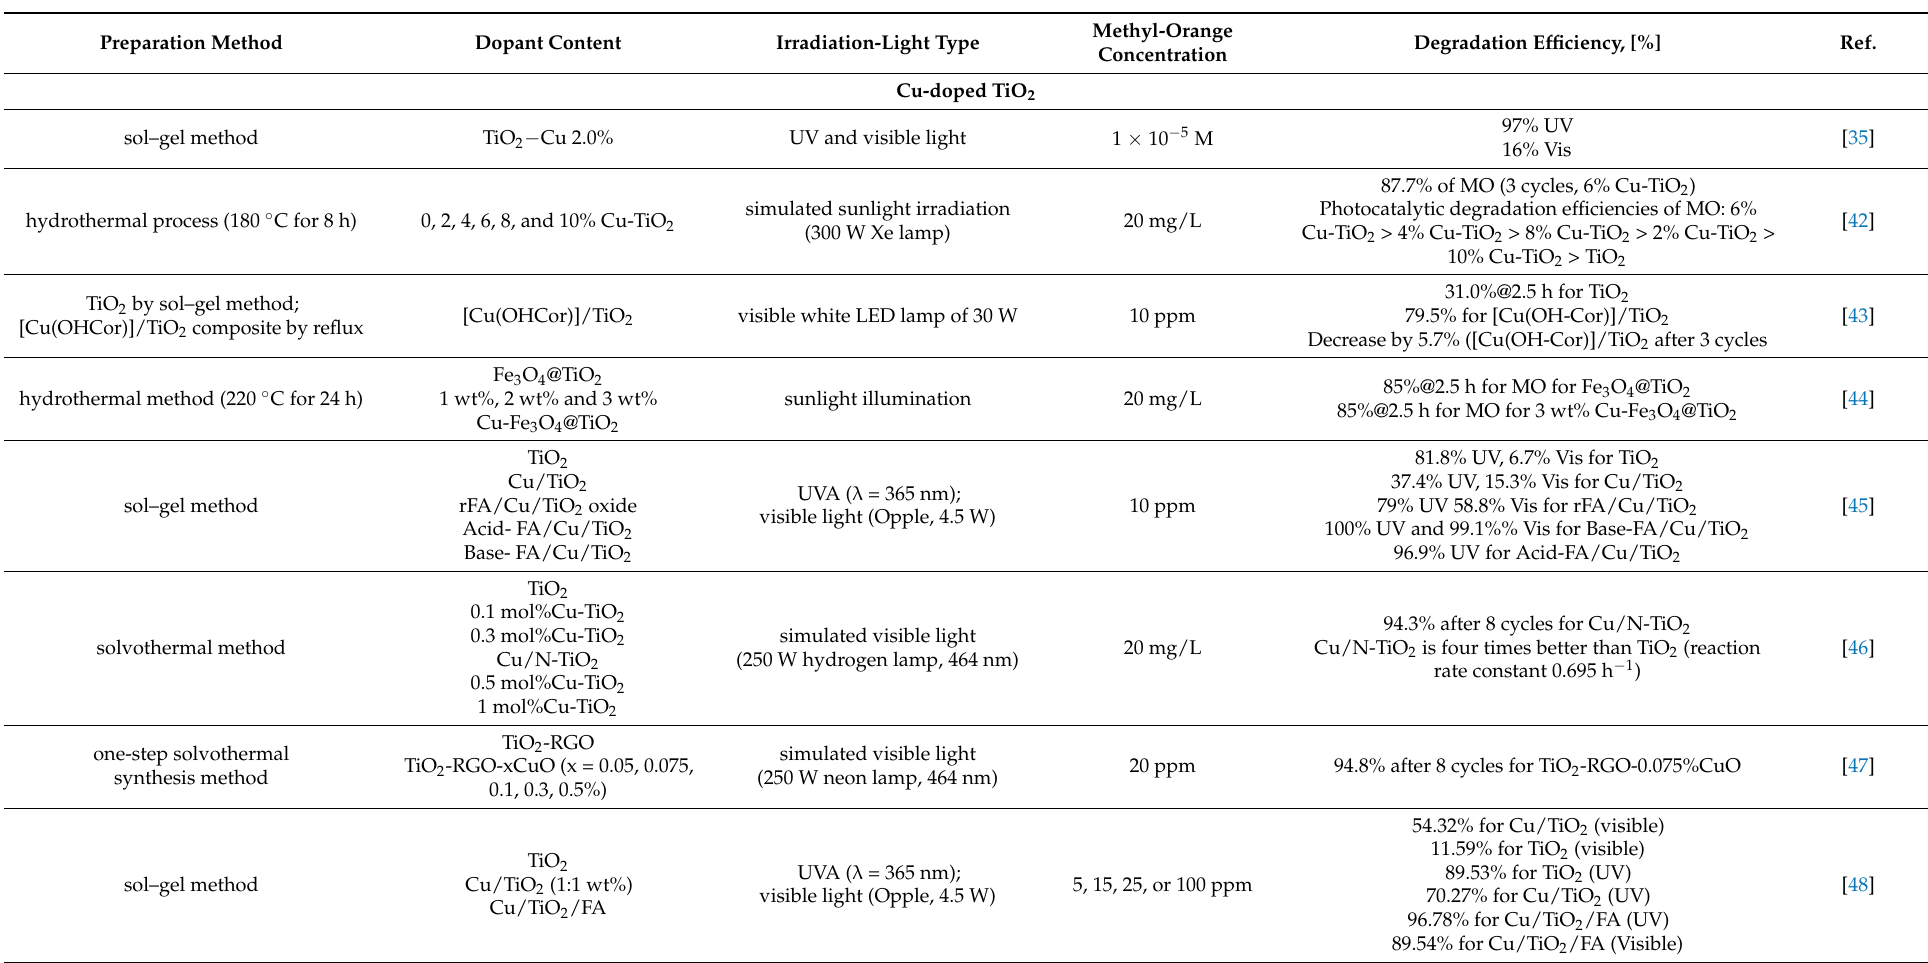
Table 1. Comparative results reported in the literature on methyl-orange photocatalytic degradation in the presence of Cu- or Zn-doped TiO 2 obtained by different